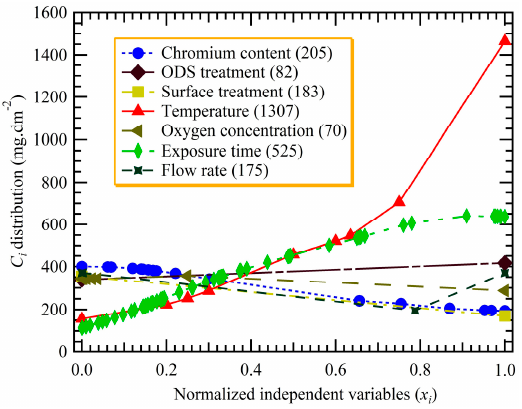
Figure 3. Fuzzy curves for the weight gain and its spanned ranges corresponding to each independent variable.